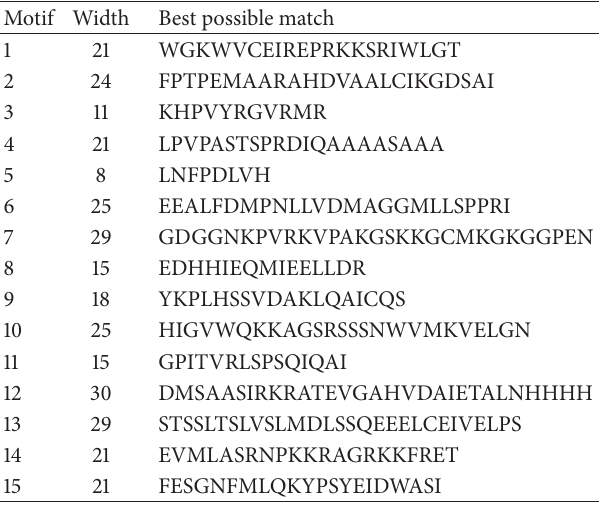
Table 3: Motif sequences of DREB genes identified in P. trichocarpa by MEME